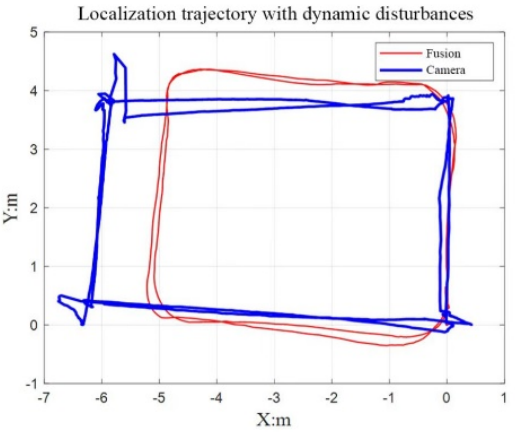
Figure 11. Track of two algorithms in dynamic interference.